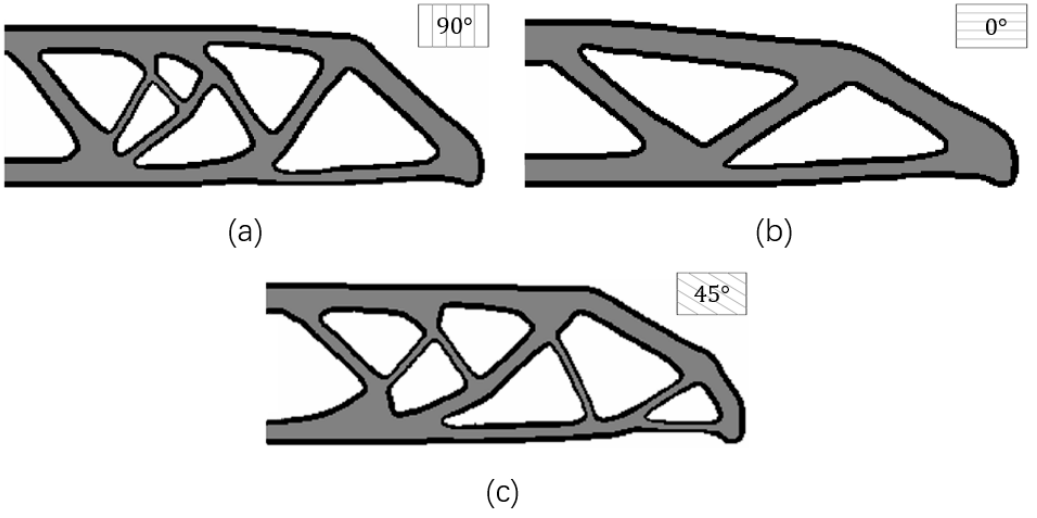
Figure 10. The optimized results with different raster directions: ( a ) 𝜃 = 90° , 𝑐 = 130.4545 ; ( b ) 𝜃 = 0° , 𝑐 = 88.3850 ; ( c ) 𝜃 = 45° , 𝑐 = 132.0675 .